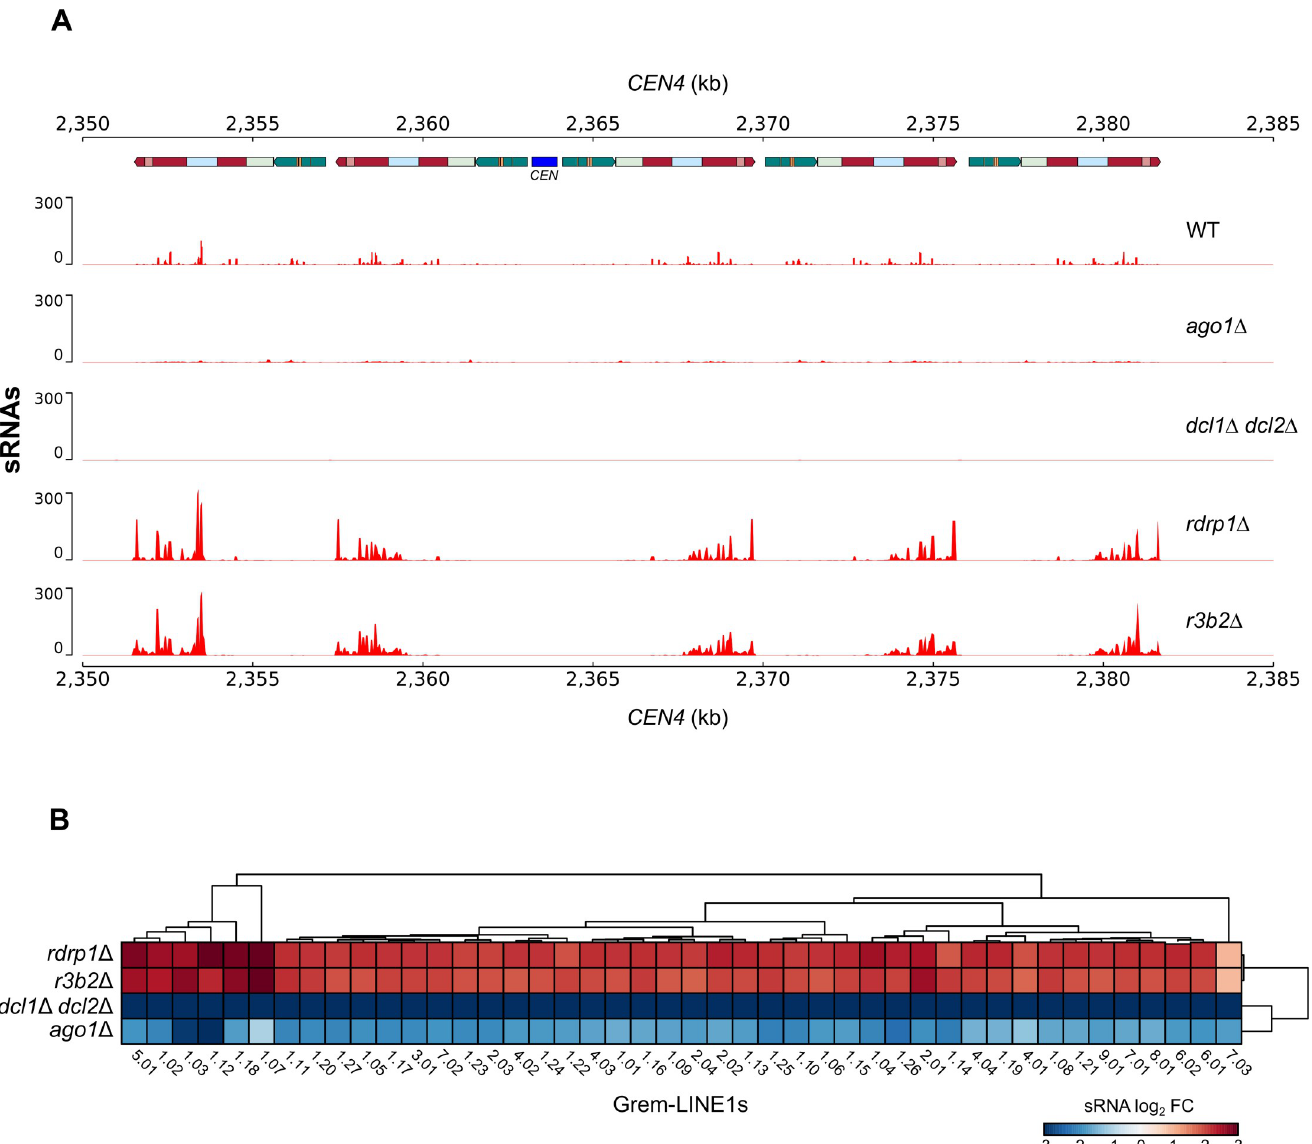
Fig 6. NCRIP competes with the epimutational pathway to regulate transposable elements. (A) A genomic view of centromeric chromatin ( CEN4 ) displaying the kinetochore-binding region enrichment that marks the centromere ( CEN , blue), annotation of transposable elements (colored blocks), and transcriptomic data of sRNAs (red) in M . circinelloides wild-type, canonical pathway ( ago1 Δ , double dcl1 Δ /dcl2 Δ ) and NCRIP ( rdrp1 Δ and r3b2 Δ ) deletion mutant strains after 48 h of growth in rich medium. sRNA values are normalized to bins per million (BPM) mapped reads. (B) Heatmap of the differential sRNA accumulation targeting Genomic retrotransposable elements of Mucoromycotina LINE1-like (Grem-LINE1s) in the depicted RNAi mutants compared to the RNAi-proficient wild-type strain. Grem-LINE1s are numbered according to Navarro-Mendoza et al. classification [12]. Differential sRNA values (in log 2 CPM) are normalized by the trimmed mean of M values (TMM). https://doi.org/10.1371/journal.pgen.1008611.g006 the transcript, with a defined length of 21–24 nt and uracil at the 5’ position [17]. On the con- trary, NCRIP sRNAs have a strong strand bias being mostly sense, a uniform size distribution (16–29 nt), and uracil in the second-to-last position [10]. We searched for these structural fea- tures in the sRNAs sequences from Grem-LINE1s and compared them to the sRNAs produced by two control loci: one regulated by the canonical RNAi pathway, coding for a serine/threo- nine kinase [17]; and other by NCRIP, coding for an alkaline phosphatase [10] (Fig 7). In the